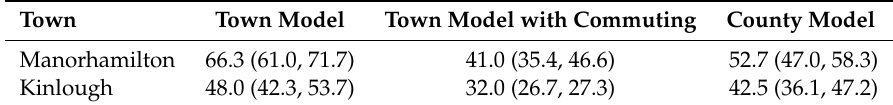
Table 5. Results for the town models and the county